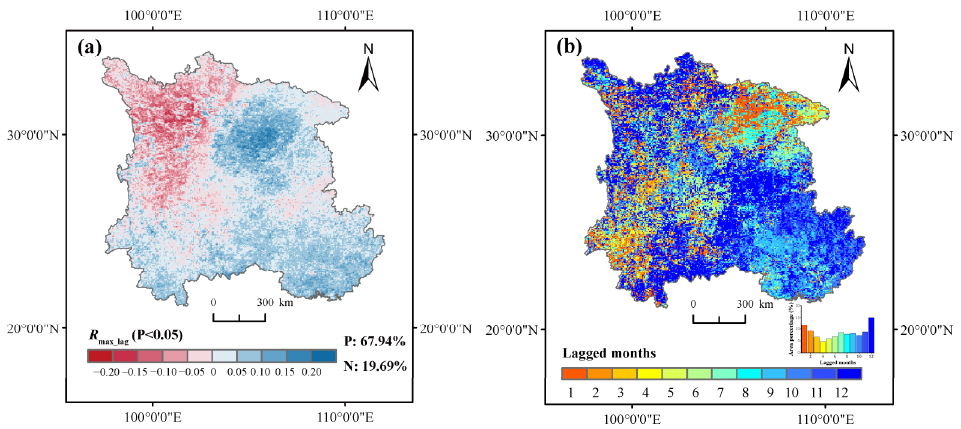
Figure 14. ( a ) Spatial distribution of the R max _ lag between SPEI and NDVI from 1990 to 2018. ( b ) Spa- tial distribution of time-lagged months when R max _ lag occurred.